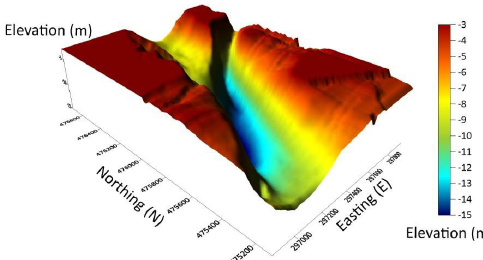
Figure 19. A 3D DSMM bathymetric plan relative to the DSMM tide gauge in 2017